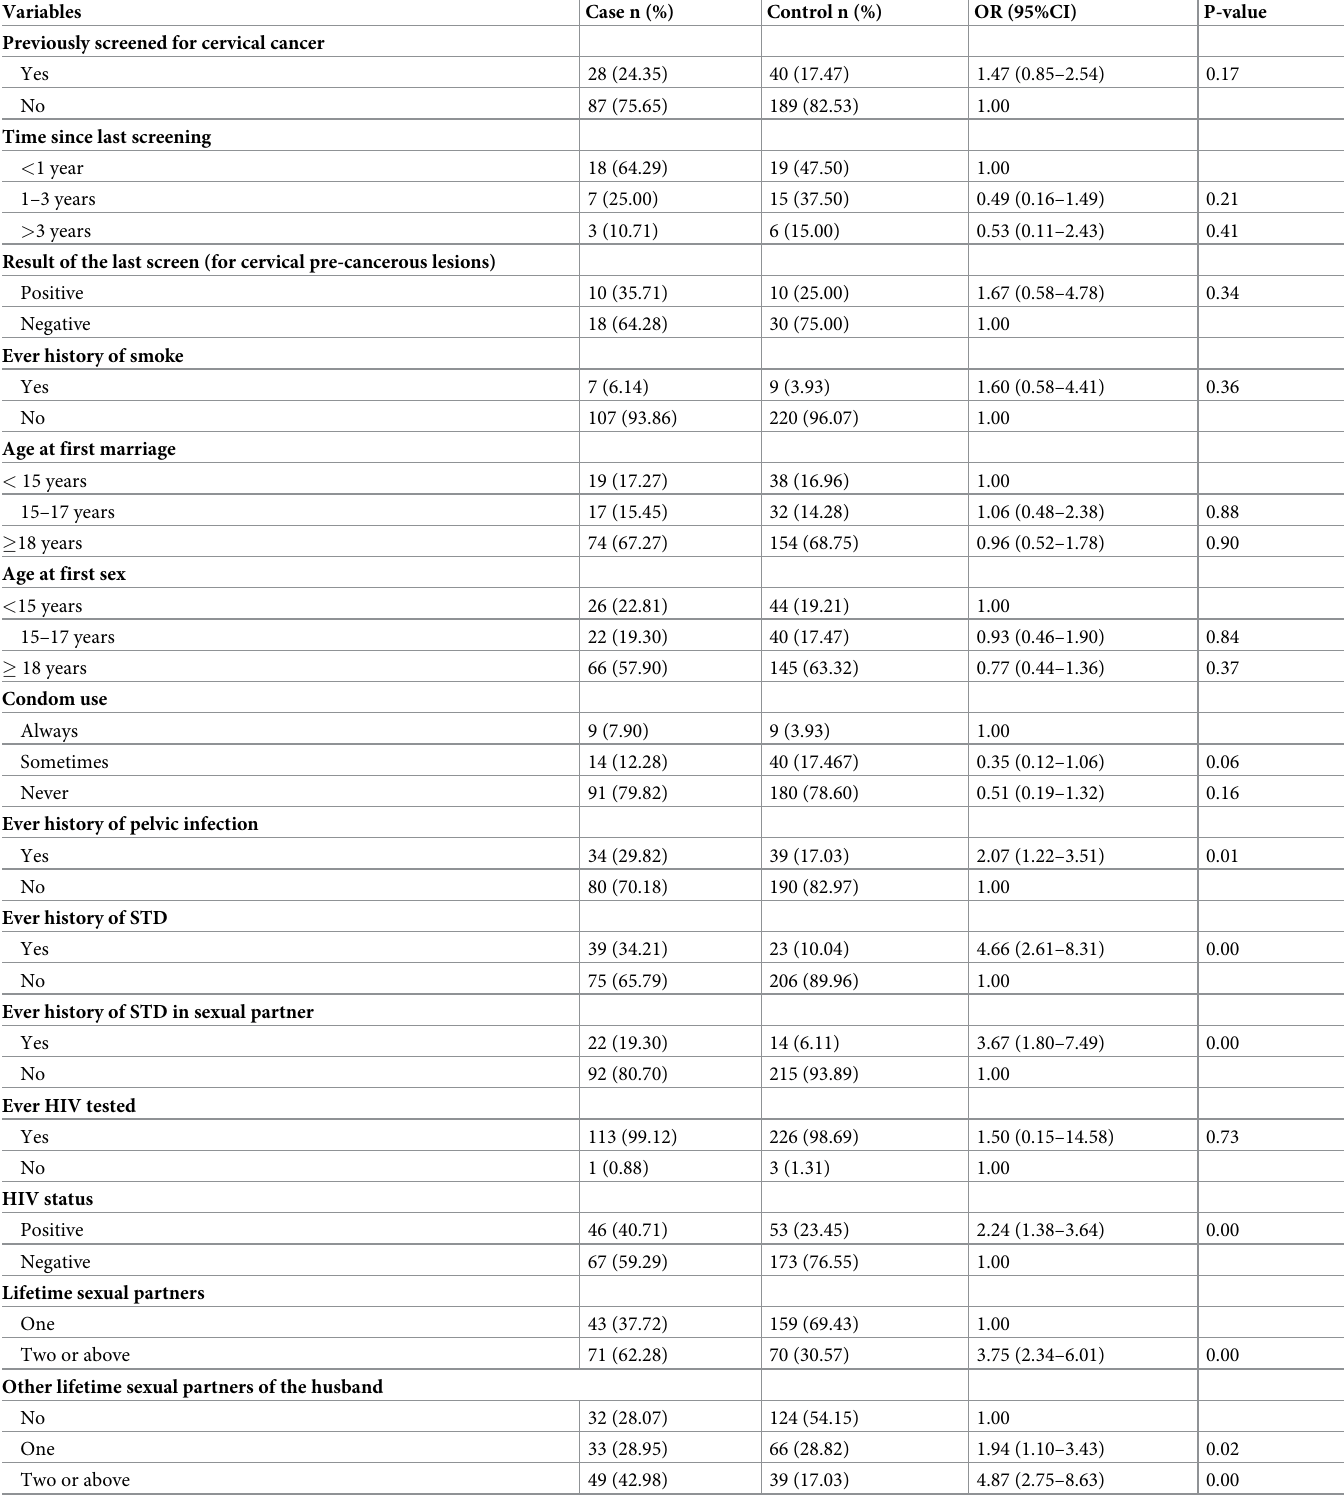
Table 3. Lifestyle and sexual behavior characteristics of screened women in Addis Ababa, Ethiopia,